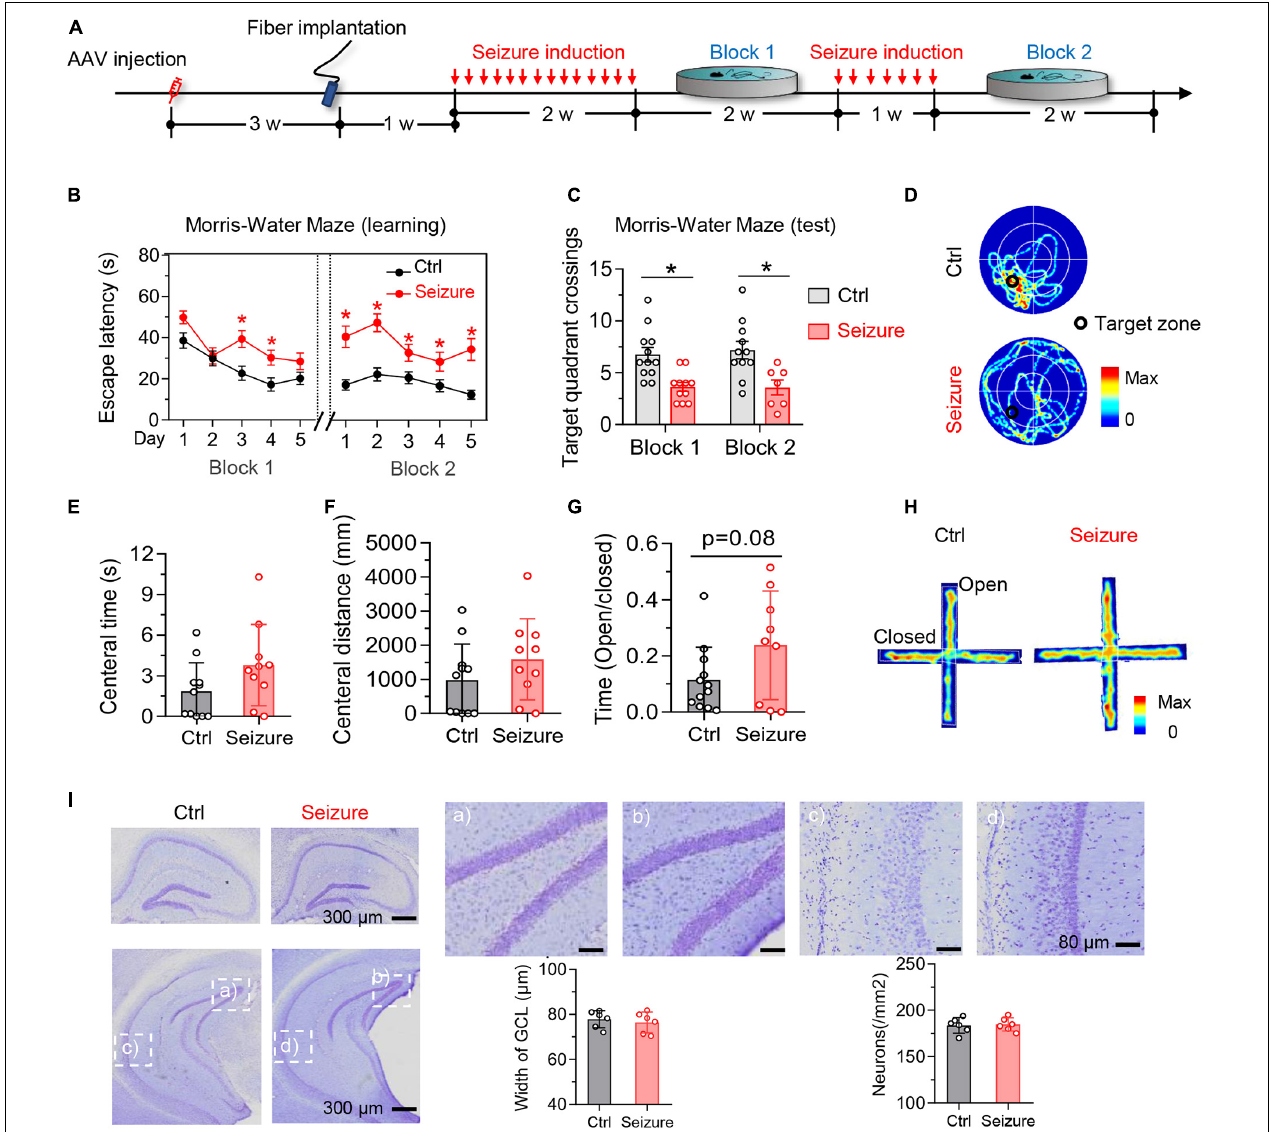
FIGURE 2 | Optogenetic induction of repeated seizures impairs spatial learning and memory without causing anxiety-like behaviors or hippocampal neuron loss in mice. (A) Experimental procedures of virus injection, optic fiber implantation, optogenetic seizure induction, and behavioral tests. (B) Repeated seizure induction caused spatial learning deficits shown by the increased escape latency during training phase. Repeated-measures ANOVA followed by Tukey multiple-comparisons tests, * p < 0.05. (C,D) Repeated seizure induction caused spatial memory deficits shown by the decreased number of target quadrant crossings in water maze test (B) and the representative heatmaps (C) show traveling time and the trace. Unpaired t test, * p < 0.05. (E,H) Repeated but controllable seizures did not induce anxiety-like behavior shown by the unchanged central time (D) and traveled distance (E) in open field test, and the increased open arm stay during elevated plus maze test (F) . The representative heatmaps (G) show traveling time and the trace. Unpaired t test, * p < 0.05. (I) Repeated but controllable seizures did not induce neuron loss in the granular cell layer (GCL) of dorsal and ventral hippocampus measured by Nissl staining ( p > 0.05). Scale bars were as indicated in each panel. n = 6 mice in each group. Unpaired t tests. Values are presented as the mean ± SEM.